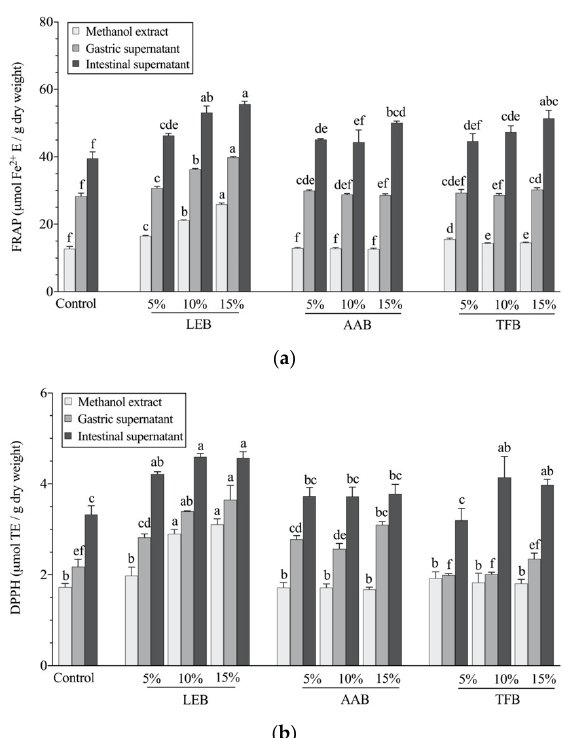
Figure 2. In vitro bio-accessible antioxidant activity of mushroom-enriched sorghum biscuits assessed by Ferrous reducing antioxidant power (FRAP, a ) and Diphenyl-2-picrylhydrazyl radicals scavenging ability (DPPH, b ). Values are means ± standard deviation (n = 3). The statistical analysis of significance was performed between 10 of the biscuit samples for each fraction (methanol extract, gastric supernatant and intestinal supernatant). Products with different letters are significantly different ( p < 0.05). LEB— L. edodes biscuit; AAB— A. auricula biscuit; TFB— T. fuciformis biscuit. The digestion process, whereby food is exposed to digestive enzymes and variations in pH, is crucial to cause the release of phenolic compounds from the molecules that have bound them [49] The released phenolic compounds are the main contributor to the anti- oxidant properties [50], however, other molecules associated with the binding or trapping of phenolic compounds can also affect the antioxidant activity. Compared with the con- trol, sorghum biscuits enriched with L. edodes had increased the antioxidant activity (FRAP and DPPH) in both gastric and intestinal fractions. T. fuciformis 10% and 15% en- riched biscuits also had increased ( p < 0.05) antioxidant activities after digestion. A. auric- ula 15% enriched biscuits had higher FRAP values in the upper gastrointestinal tract than the control samples, but the addition of A. auricula did not increase DPPH values. The FRAP assay is based on the reduction of ions from Fe 3+ to Fe 2+ , and the DPPH reagent can receive hydrogen atoms from antioxidants [20]. That means that the antioxidant com- pounds assessed by the DPPH are not the same as that of FRAP. The antioxidant activity of food after gastrointestinal digestion is vital for health. For example, antioxidants can scavenge and suppress the excess reactive oxygen species (ROS) in the organisms and prevent oxidative-related diseases [51]. Otherwise, excessive ROS causes inflammation which leads to diseases, such as inflammatory bowel disease.